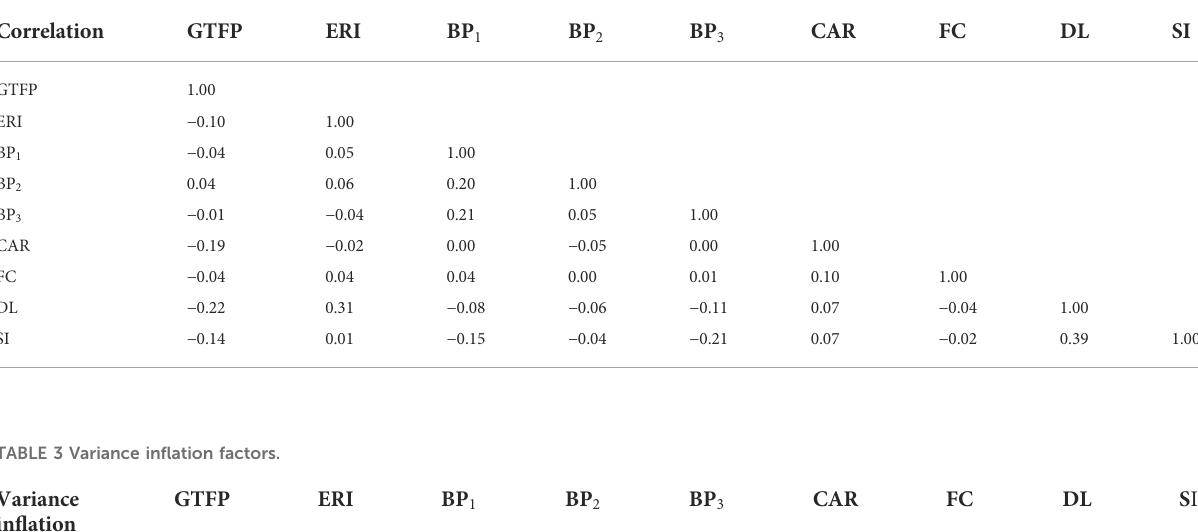
TABLE 2 Correlation coef fi cients.